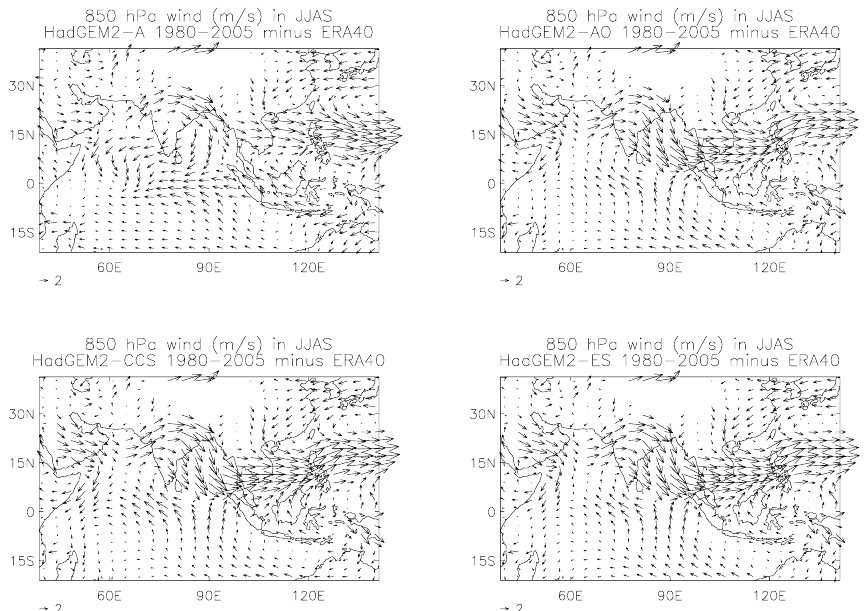
Fig. 2. As Fig. 1 but for horizontal wind at 850hPa compared with ERA40 reanalyses (Uppala et al., 2005).